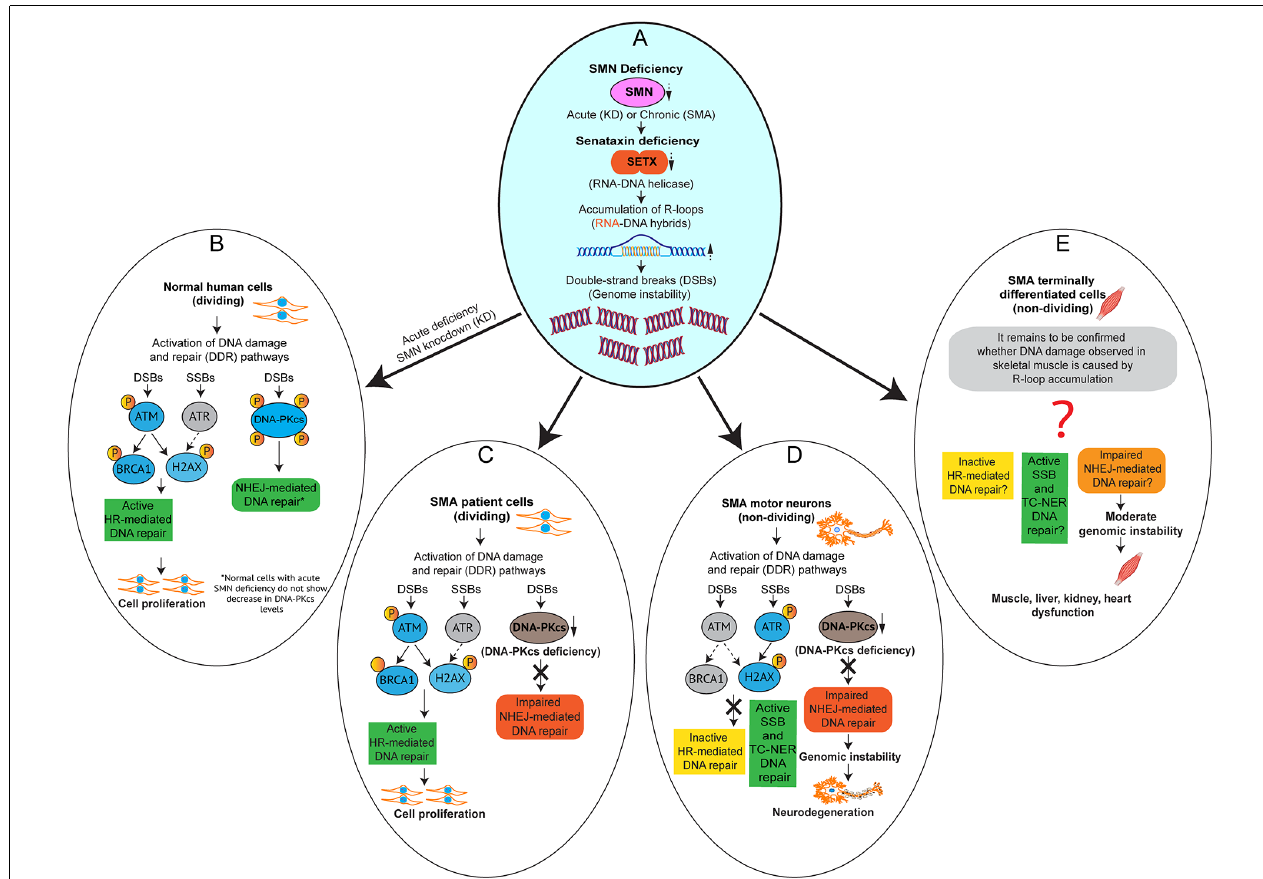
FIGURE 4 | Impaired NHEJ-mediated DNA repair causes genomic instability and selective degeneration of motor neurons in SMA. Graphical models (A–E) showing the activation DNA damage response (DDR) pathways caused by acute and chronic SMN-deficiencies, which result in R-loop accumulation leading to DNA damage in SMN-deficient cells. (A) SMN deficiency, acute (knockdown of SMN) and chronic (SMA) result in downregulation of SETX, which causes accumulation of R-loops and DNA damage. (B) Acute SMN-deficiency in normal human dividing cells causes activation of DDR and Homologous recombination (HR) and non-homologous end joining (NHEJ) DNA repair pathways. (C) Chronic SMN-deficiency in SMA patient dividing cells causes activation of DDR and HR to repair double-strand breaks (DSBs) but NHEJ pathway is impaired due to downregulation of DNA-PKcs, a critical factor required for NHEJ-mediated DSBs repair. (D) Chronic SMN-deficiency